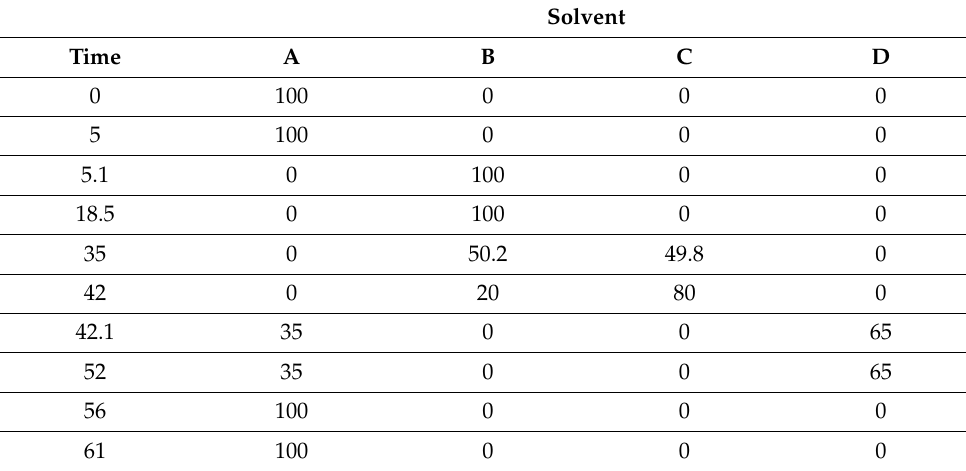
Table 2. Reverse phase gradient